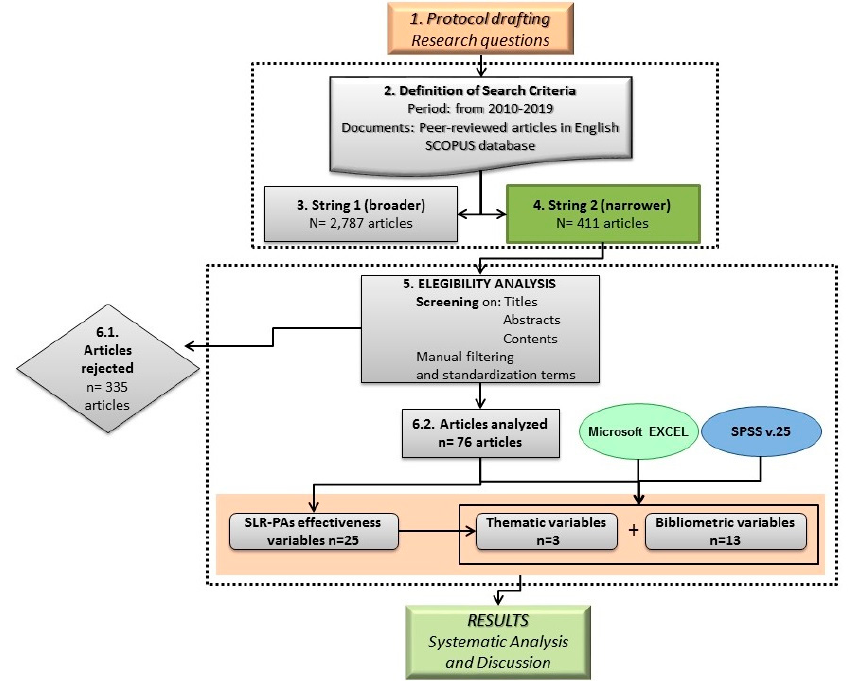
Figure 1. Methodological Flowchart.